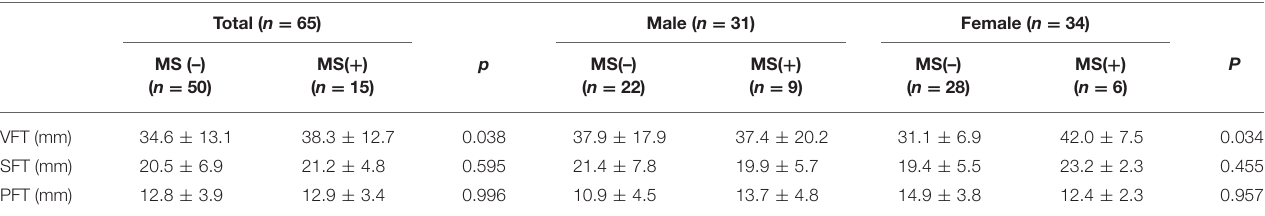
TABLE 5 | Comparison of abdominal sonographic data in the obese adolescents.